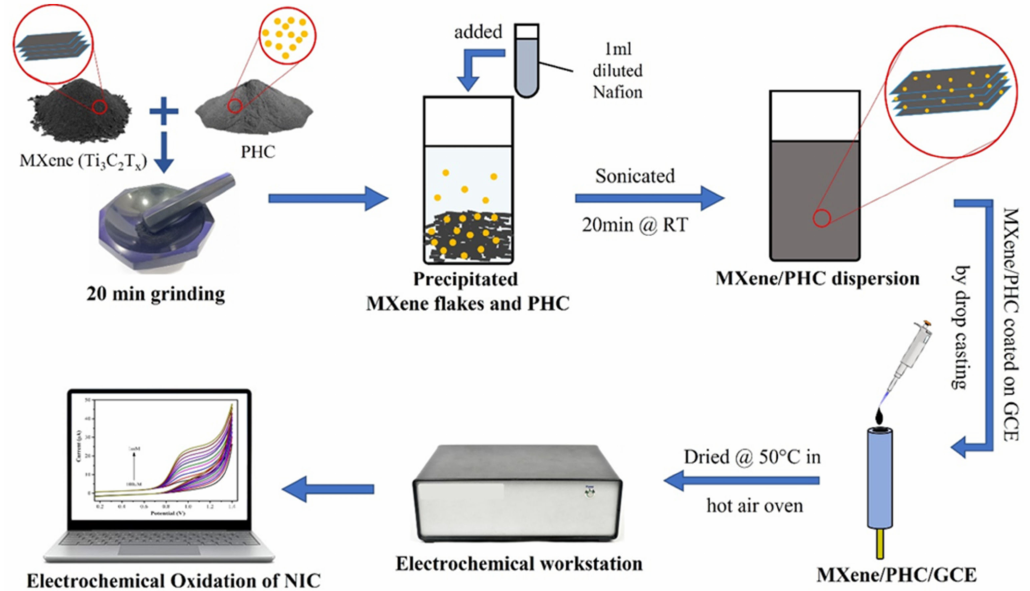
Figure 1. Schematic illustration of MXene/PHC composite synthesis for the sensor development to determine NIC